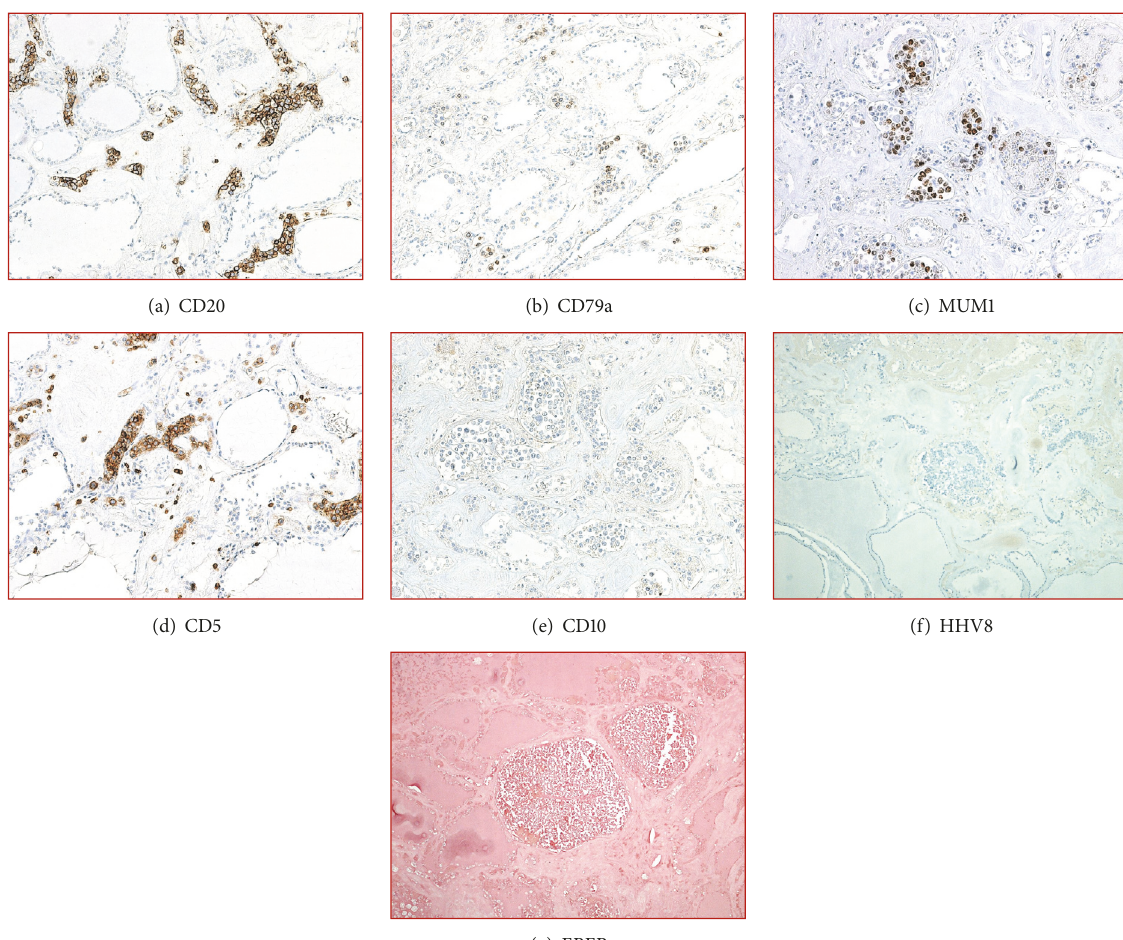
Figure 2: Immunohistochemical studies performed on thyroid gland revealed that the neoplastic lymphoid cells are positive for CD20 ((a), 20X), dim CD79a ((b), 20X), MUM1 ((c), 20X), and CD5 ((d), 20X); negative for CD10 ((e), 20X), HHV8 ((f), 10X), EBER ((g), 10X), c-MYC, BCL6, and cyclin D1 (not